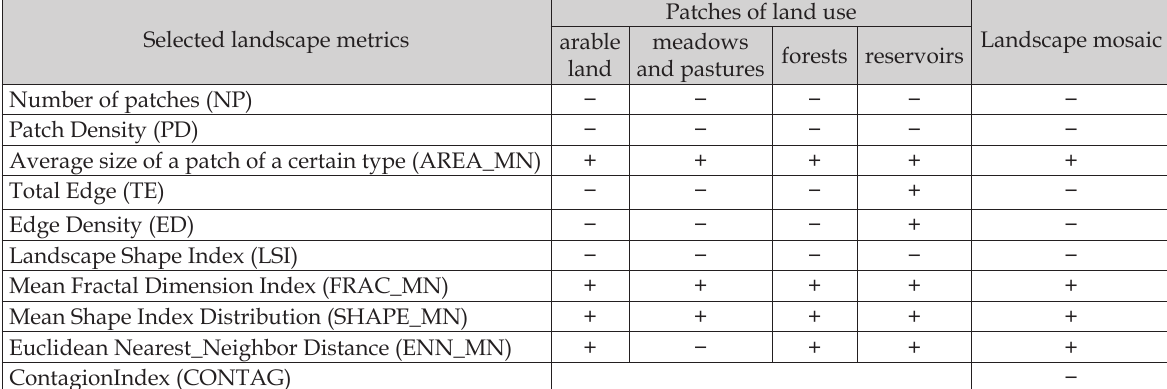
Table 3. Changes in the indicators of composition and configuration of patches of land use. Selected landscape